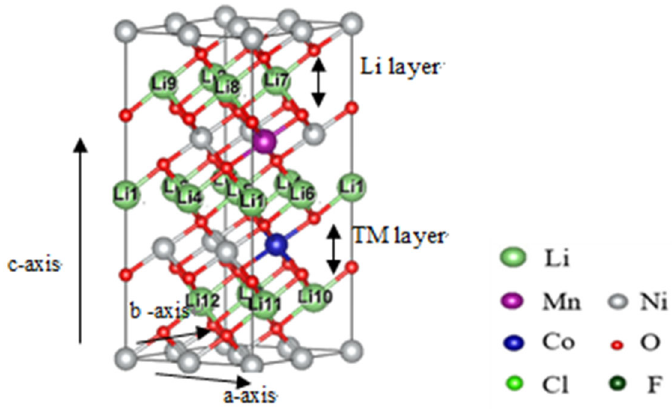
Figure 4. The arrangement of Li.